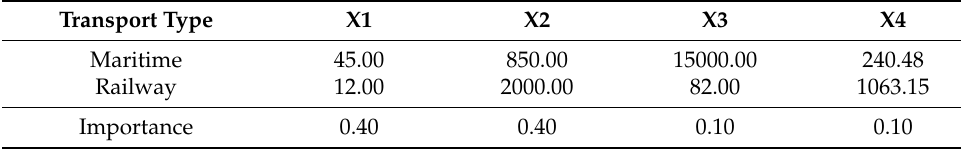
Table 1. Decision matrix for one loading unit.